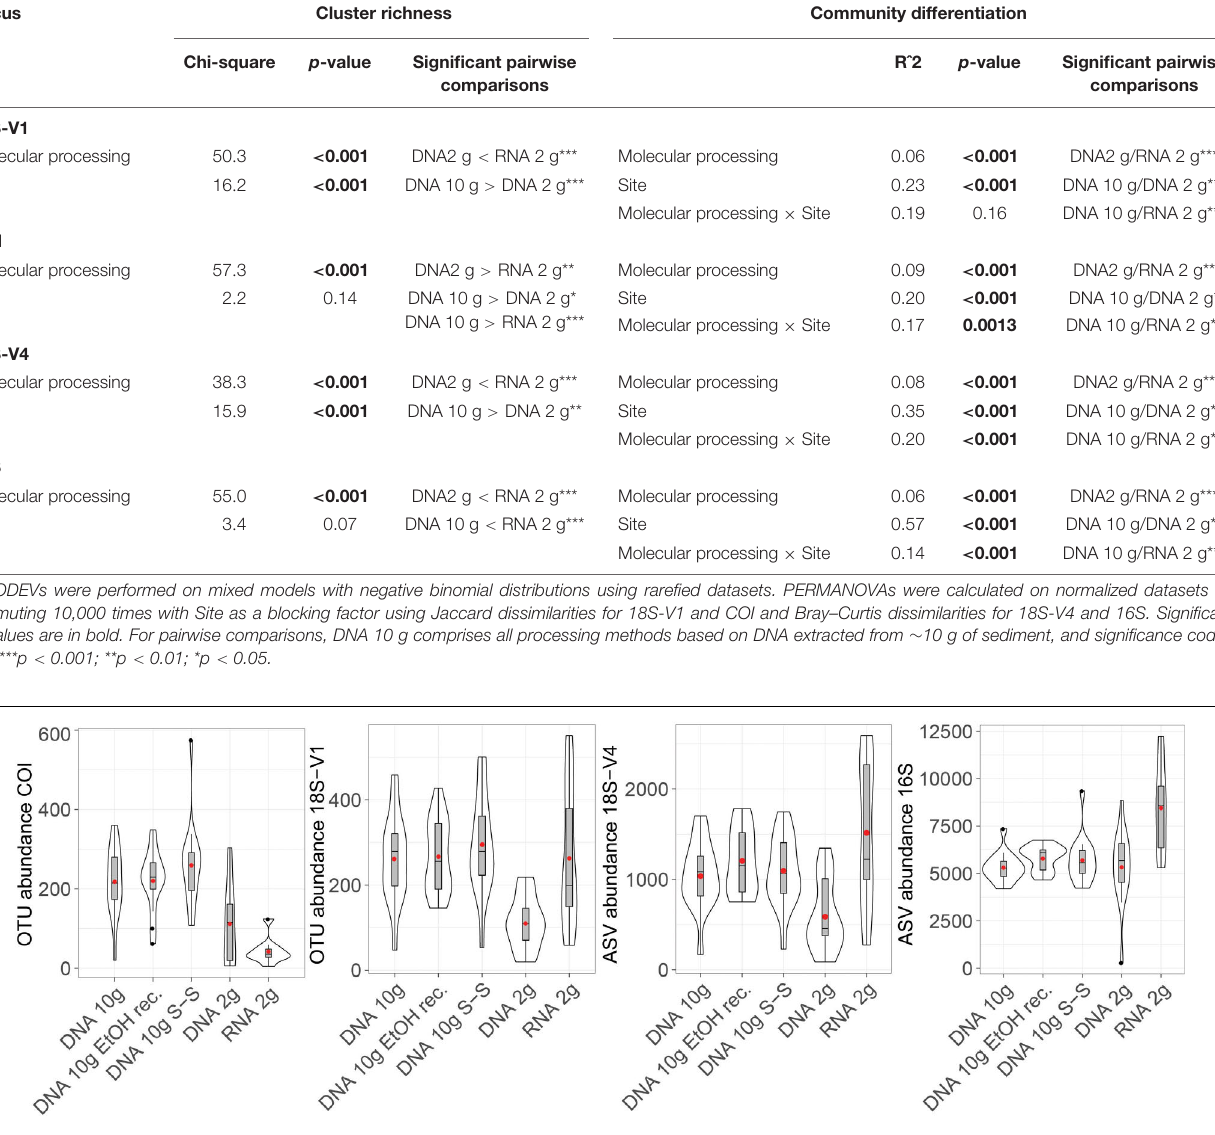
FIGURE 1 | Violin plot showing detected numbers of metazoan operational taxonomic units (OTUs) (COI, 18S-V1), micro-eukaryote (18S-V4) amplicon sequence variants (ASVs), and prokaryote (16S) ASVs recovered by the five molecular processing methods evaluated in this study (DNA 10 g: crude DNA extracts from ∼ 10 g of sediment with the PowerMax Soil kit; DNA 10 g EtOH rec EtOH reconcentrated 10 g DNA extracts; DNA 10 g S-S: size-selected 10 g DNA extracts; DNA/RNA 2 g: crude DNA/RNA extracts from ∼ 2 g of sediment with the RNeasy PowerSoil kit). Cluster abundances were calculated on rarefied datasets. Boxplots show medians with interquartile ranges. Red dots indicate mean